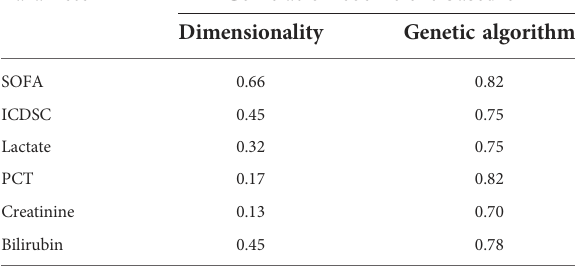
TABLE 2 Comparison of Pearson correlations of the dimensionality parameter and the principal components derived by the genetic algorithm with medical